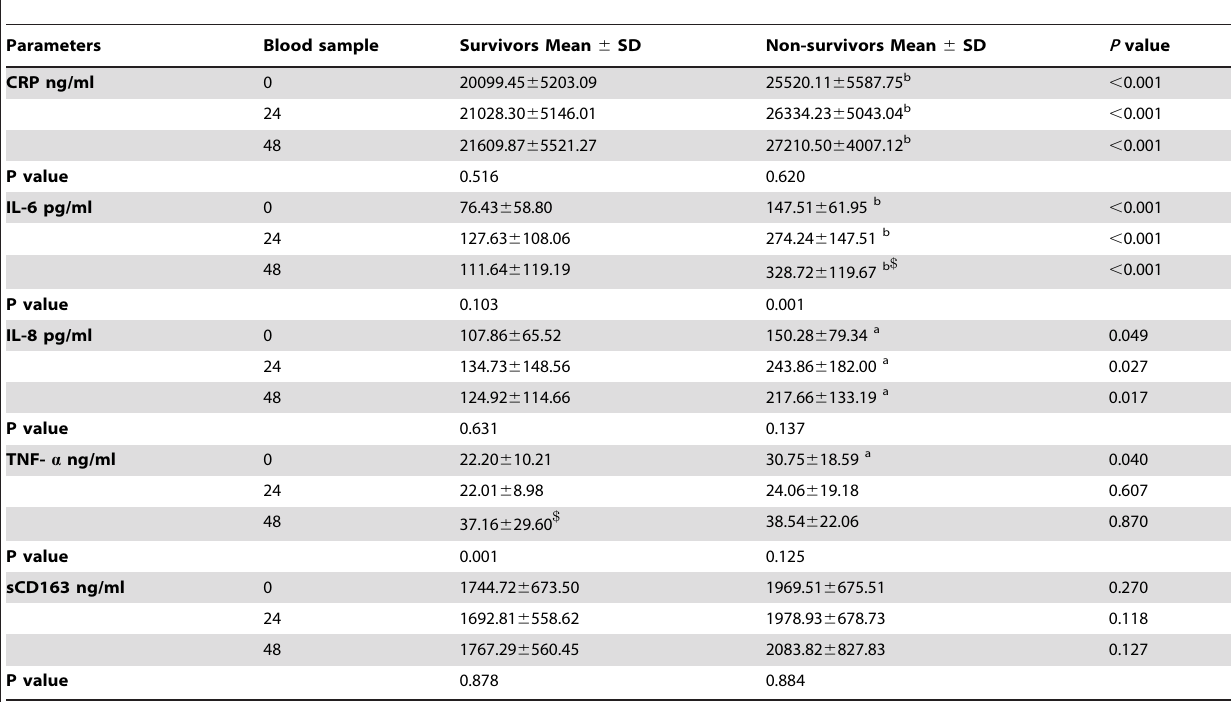
Table 4. The mean and standard deviation of the various study parameters in the survivors and non-survivors of the infected group at different time